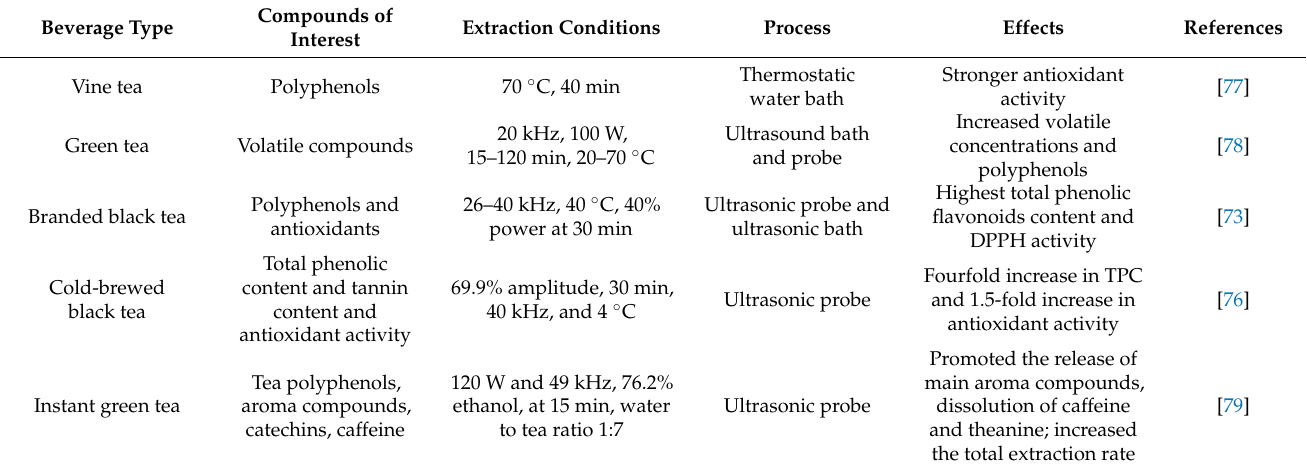
Table 2. The quality improvement of tea beverages under various ultrasonication